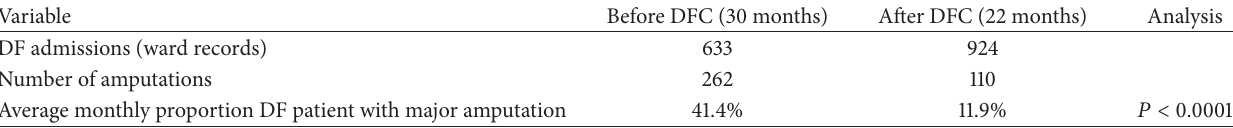
Table 1: Diabetic foot (DF) admissions and amputation rates at Georgetown Public Hospital Corporation.